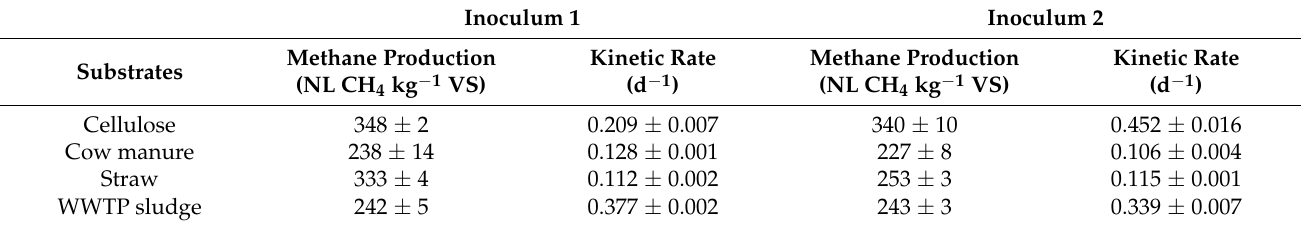
Table 4. Effect of source of inoculum on the kinetics and methane